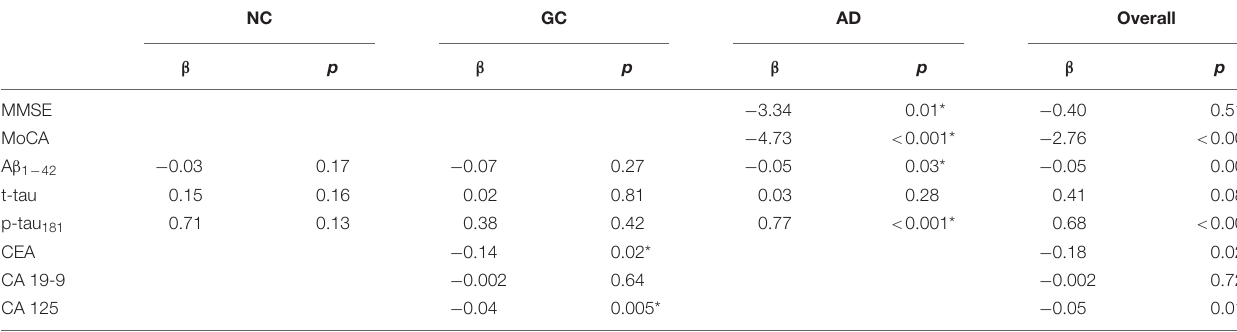
TABLE 3 | Multiple linear regression analysis: predictors of plasma NfL